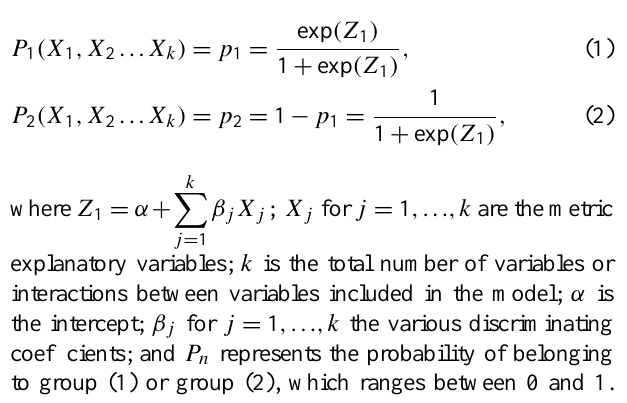
Fig. 1. Study area map. Circled area shows GFA radar range.